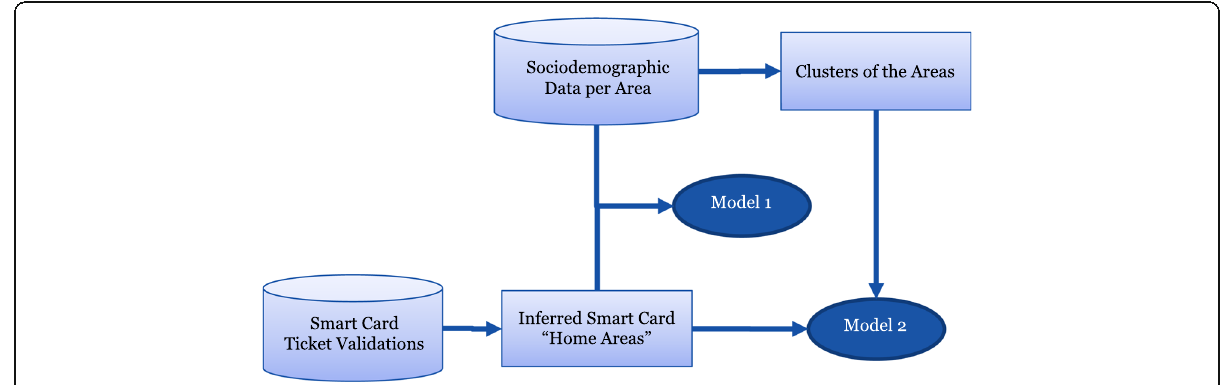
Fig. 2 Overview of the analysis